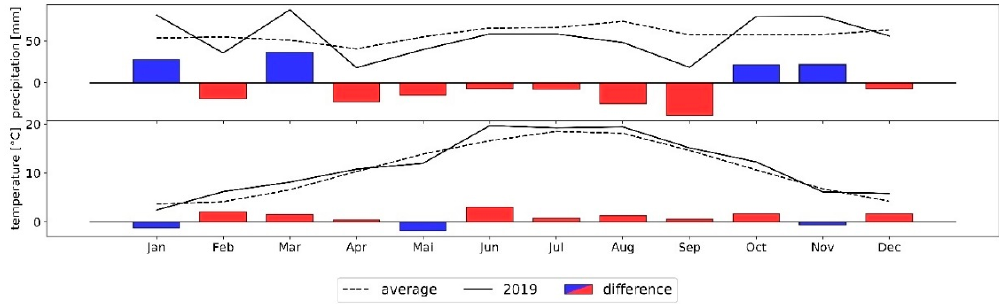
Figure 2. Precipitation and temperature measurements of 2019 compared to the long-term average (29 years). Within the period of the SARSense campaign, it was both hotter and dryer than average.